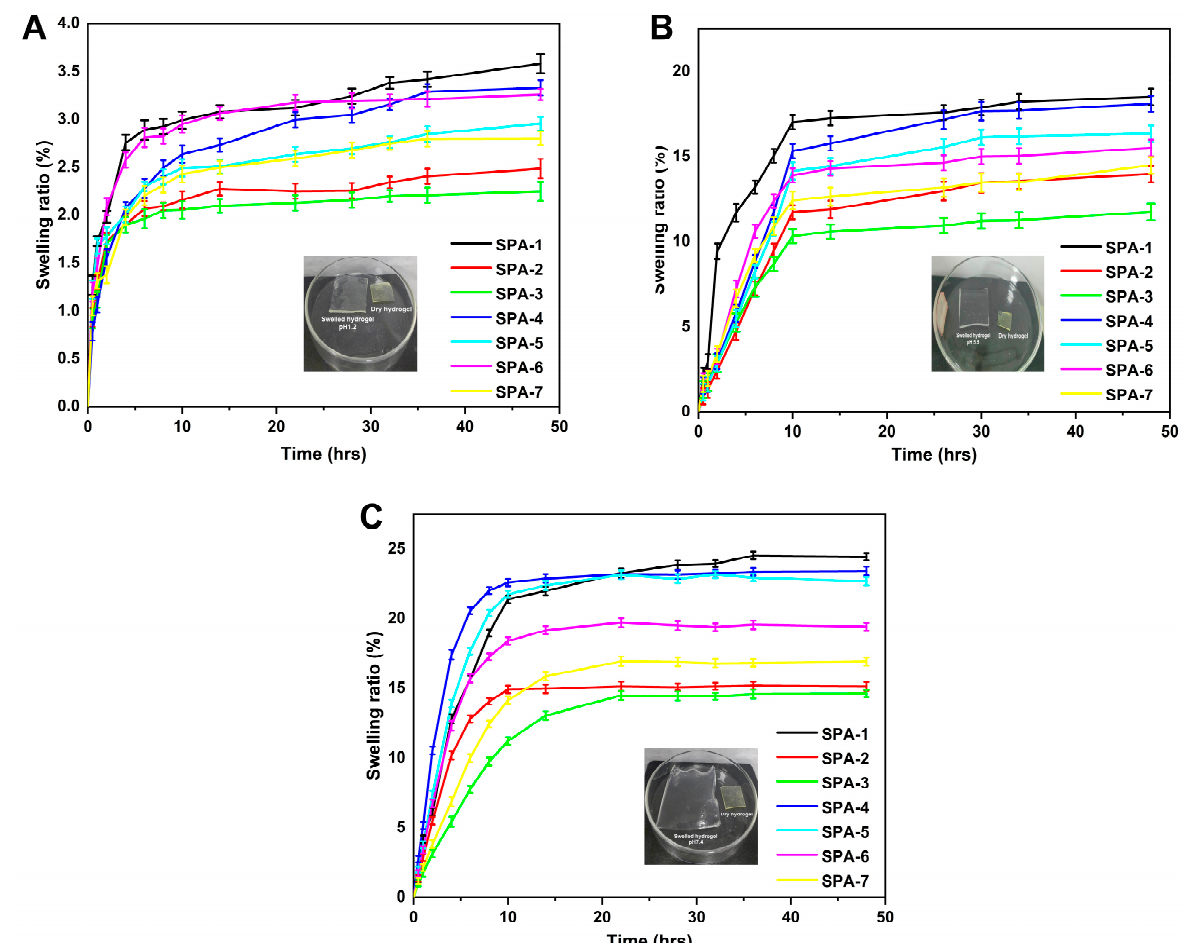
Figure 6. Swelling curve over time of a hydrogel membrane in pH of 1.2 ( A ), pH of 5.5 ( B ), and pH of 7.4 ( C